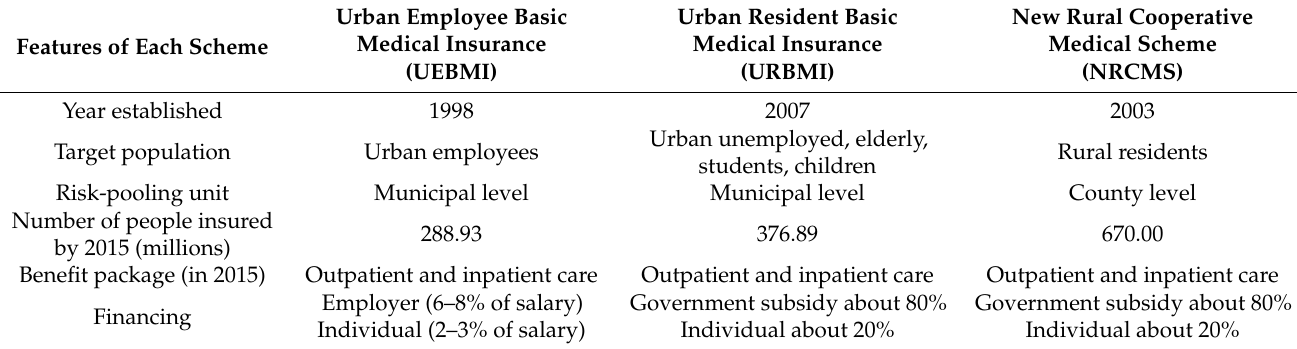
Table 1. Characteristics of the three social health insurance schemes in